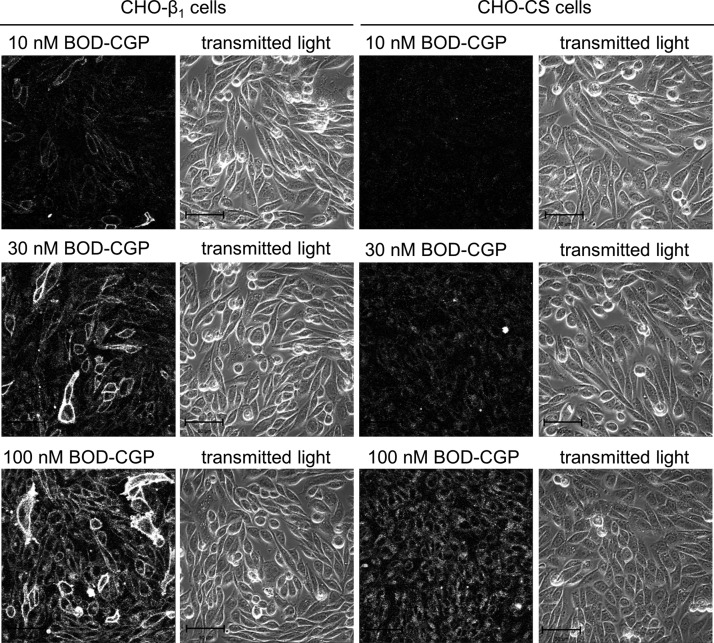
Concentration-dependent increase of BODIPY-TMR-CGP binding levels in CHO-β1 and CHO-CS cells. Confocal images of 10, 30, and 100 nM BODIPY-TMR-CGP (BOD-CGP) binding levels following 4.5 min association measured in CHO-β1 and CHO-CS cells. The microscope settings were kept constant for the recordings of fluorescence intensities of all 3 BODIPY-TMR-CGP concentrations in both CHO-β1 and CHO-CS cells to allow for direct comparison of the BODIPY-TMR-CGP binding levels. Images are representatives of a total of 5, 6, and 4 separate experiments (for 10, 30, and 100 nM BODIPY-TMR-CGP, respectively) using CHO-β1 cells, and 3, 6, and 3 separate experiments (for 10, 30, and 100 nM BODIPY-TMR-CGP, respectively) using CHO-CS cells. Scale bars, 50 μm.